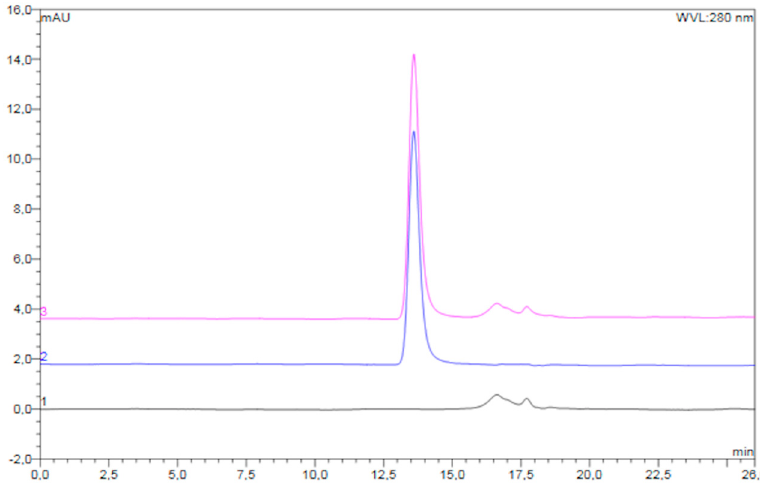
Figure 3. Overlay of typical chromatograms of the reconstituted freeze-dried placebo powder (black), unprocessed diluted pre-F (blue), and reconstituted freeze-dried pre-F-containing powder (pink). The chromatogram of the reconstituted freeze-dried pre-F-containing powder (pink) showed a clear peak with a retention time of approximately 13.6 min. In addition, several smaller peaks were observed with retention times between 16 and 19 min. The chromatogram of unprocessed pre-F (blue)